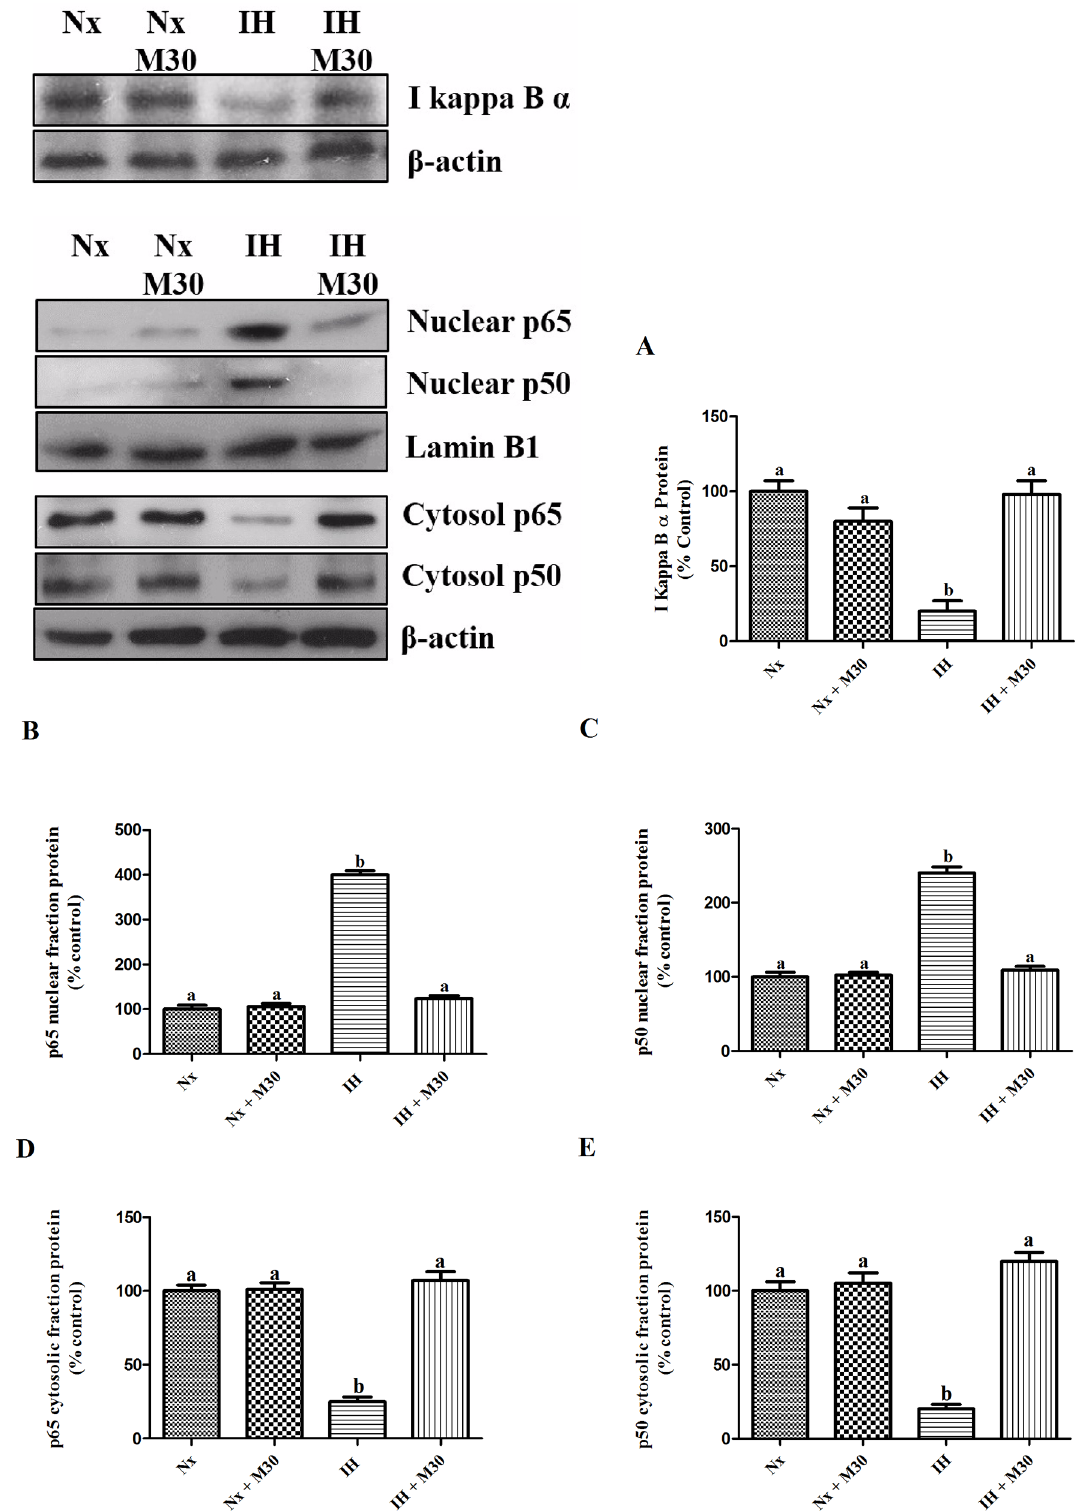
Fig 5. Hypoxia induced the degradation of I κ B α in the redox-sensitive NF κ Bcanonical pathway and the nucleus translocation of NF κ Bmember p65 and p50. Levels of (A) I κ B α , nuclearprotein expressionof (B) p65, (C) p50, cytosolic